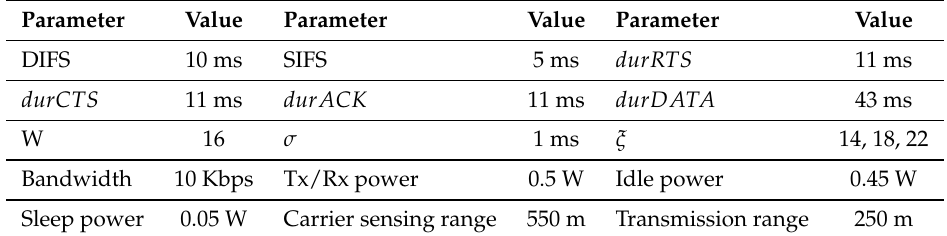
Figure 6. Network scenarios in simulations. ( a ) Single-chain network. ( b ) Double-chain network. ( c ) 2-D random network. ( d ) Grade distribution in the network after the GSE process. Table 3. Simulation